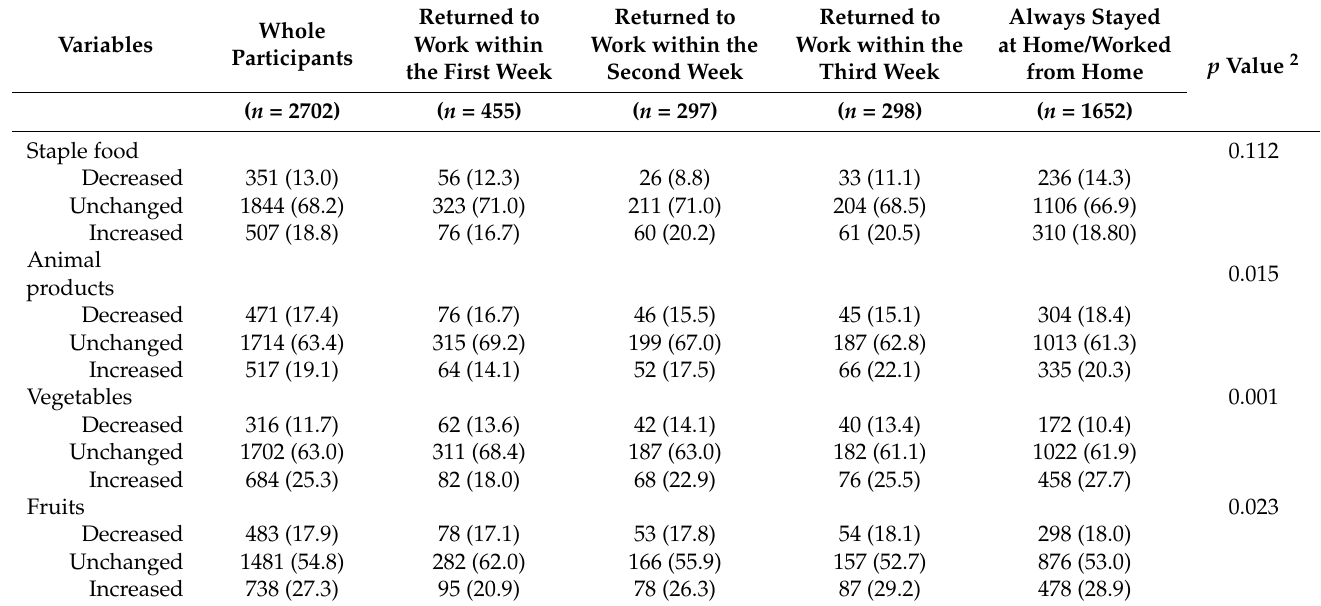
Table 5. Changes in eating habits and lifestyles during the COVID-19 lockdown by status 1